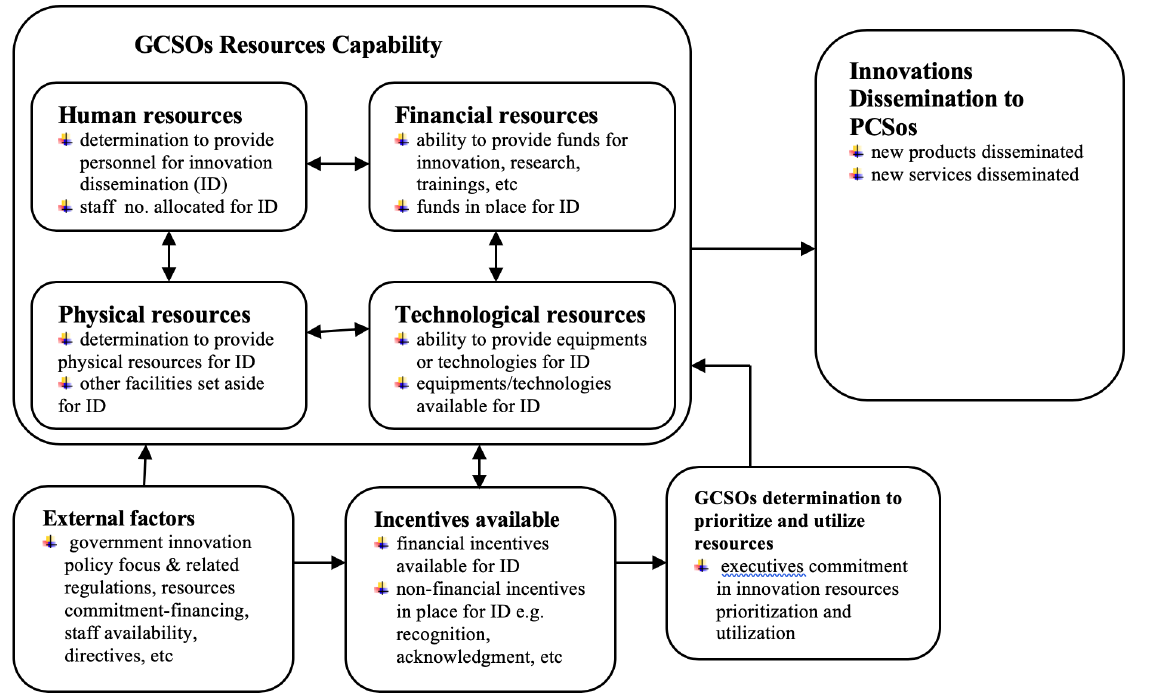
Fig. 1. The CF Summarizing Relationships between GCSOs Resources Capability and Innova- tions Dissemination (ID) to PCSos (Source: Own